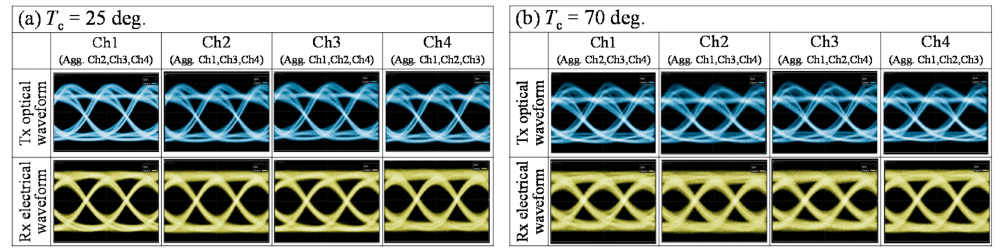
Figure 10. Measured waveforms ( a ) T c = 25 ◦ C and ( b ) T c = 70 ◦